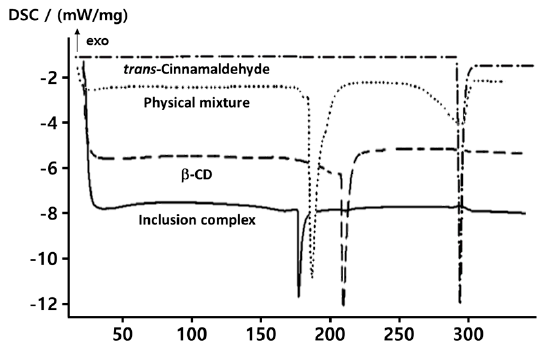
Figure 1. Thermal analysis of trans -cinnamaldehyde ( t CIN) and β -cyclodextrin ( β -CD) inclusion complexes (CIs). The CIs were obtained by the molecular inclusion of t CIN and β -CD at a molar ratio of 1:1. The physical mixture was obtained by pulverizing the two components in a glass mortar and mixing them accurately in a molar ratio of 1:1.